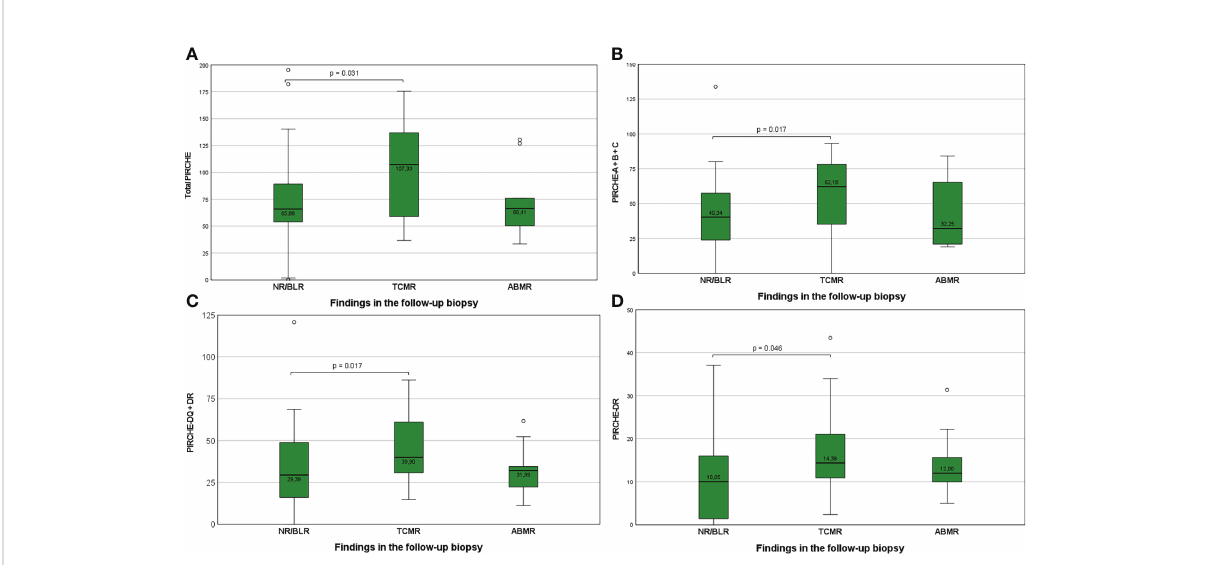
FIGURE 3 (A-D) Higher total PIRCHE-II scores (A) , PIRCHE-II scores for HLA-A, -B, and -C loci mismatches (B) , PIRCHE-II scores for HLA-DQ and -DR loci mismatches (C) , and PIRCHE-II scores for HLA-DR locus mismatches (D) among KTRs who develop TCMR compared to KTR with NR/BLR. Boxplots show median, interquartile range (IQR), and 95 th percentile.